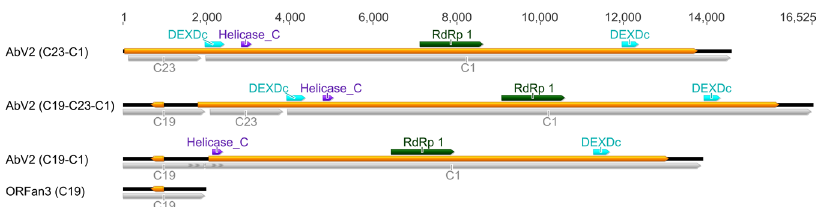
Figure 2. Inferred genome structure of the three AbV2 modular variants, AbV2 (C23-C1), AbV2 (C19- C23-C1) and AbV2 (C19-C1), and the associated ORFan ORFan3 (C19). Predicted ORFs greater than 300 bases are shown as yellow annotations. Grey annotations indicate size and position of sequenced contigs. Scale is length in